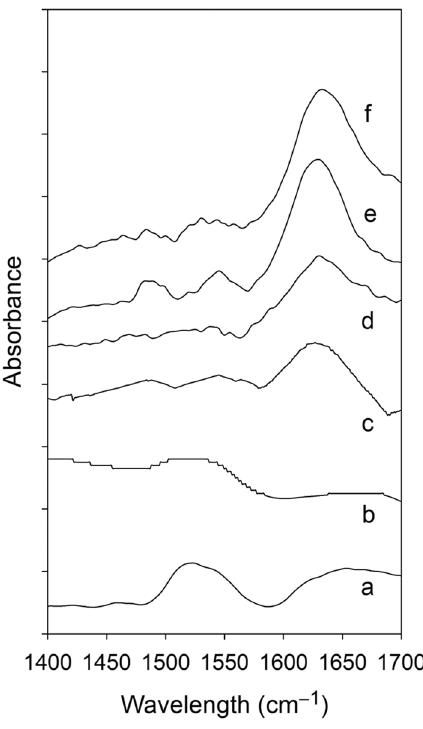
Fig. 7 FTIR spectra of the pyridine adsorbed catalysts: a B300, b BC0.7, c BC27, d BC5.7, e BC11.1, and f BC48